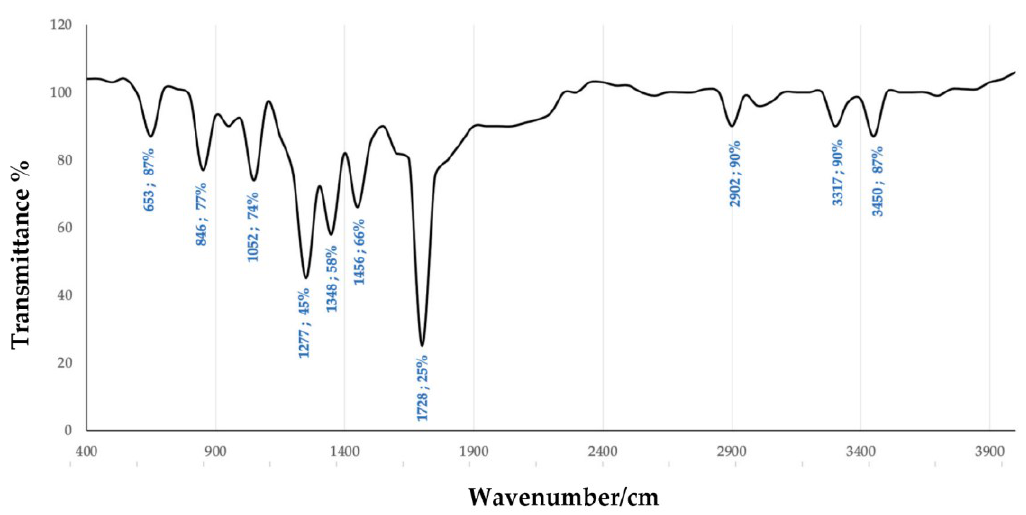
Figure 11. FTIR spectrum of putative PHB extracted from strain 1B.